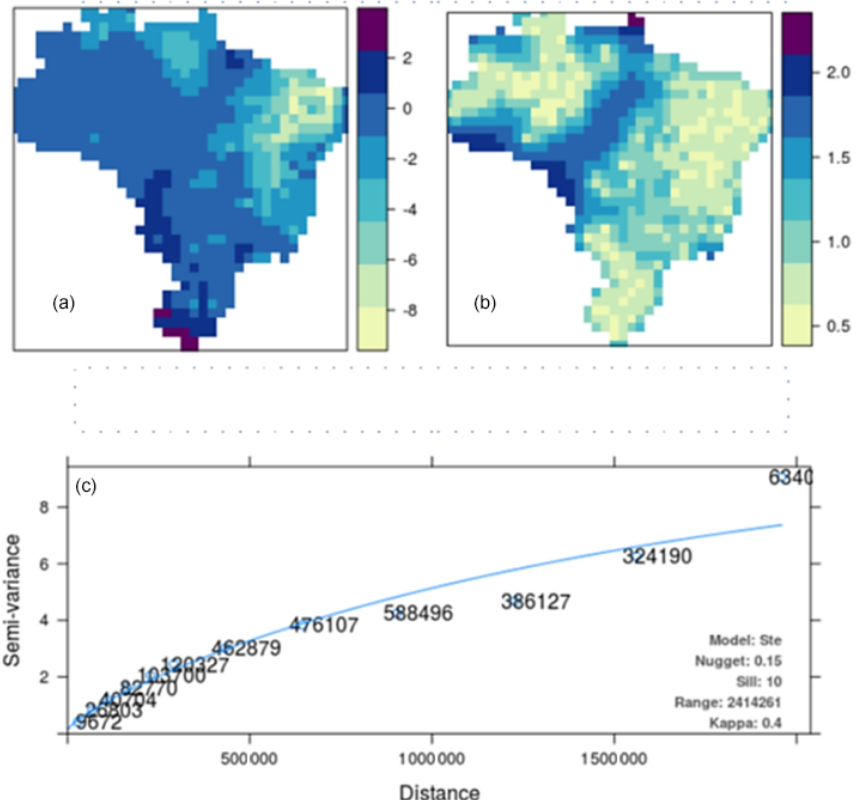
Figure 6. Geostatistical analysis (ordinary Kriging modeling with automatic variogram fitting) of satellite soil moisture across Brazil from 2009 to 2015. (a) The trend prediction of soil moisture for 2009–2015. (b) The Kriging variance (error map). (c) Variogram fitting parameters and spatial autocorrelation model (blue line) supporting the soil moisture prediction. The numbers around the blue line are the pairs of points available for the interpolation at a specific distance ( x